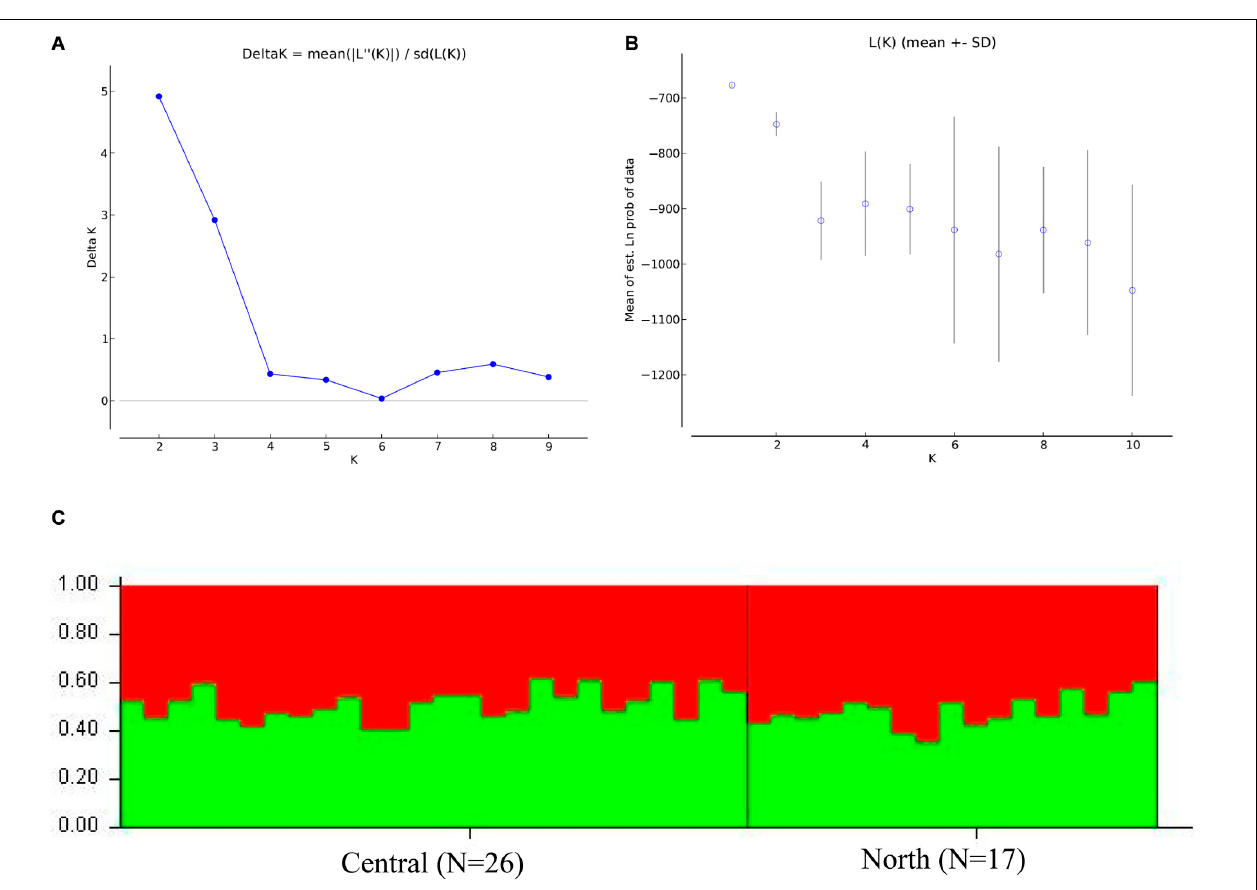
FIGURE 4 | Bayesian clustering analysis inferred with the program Structure 2.3.2 for ten microsatellite loci of franciscana ( Pontoporia blainvillei ) of FMAIa: (A) (cid:49) K from Evanno’s method is shown between successive K values, (B) mean log probability (Lk) is given for each K tested, and the (C) assignment probabilities of individuals to putative population clusters at K = 2 according to sampling putative